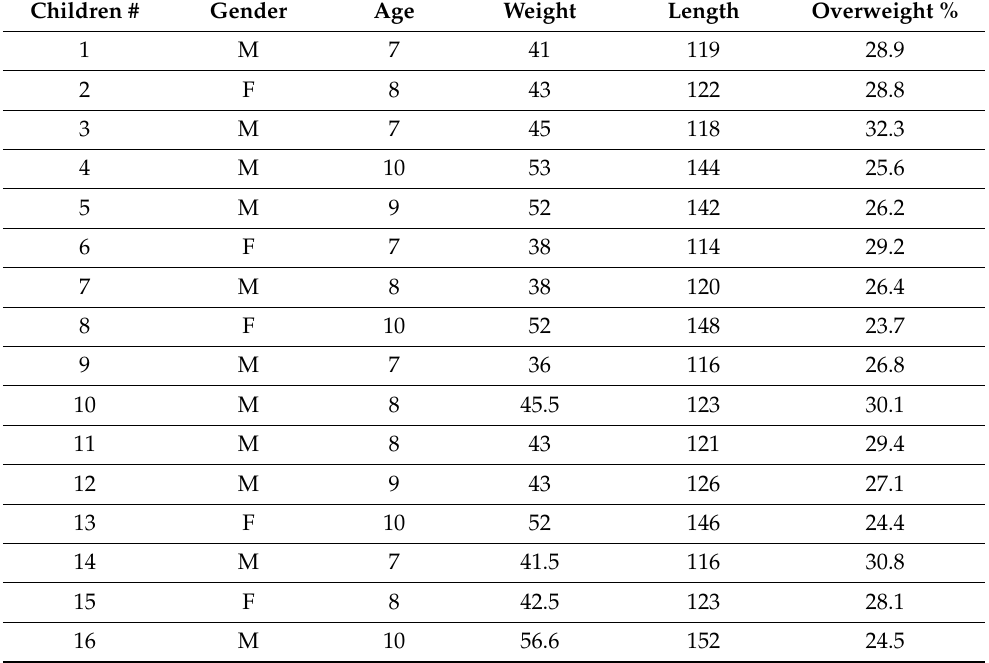
Table 1. General information about the participants (obese